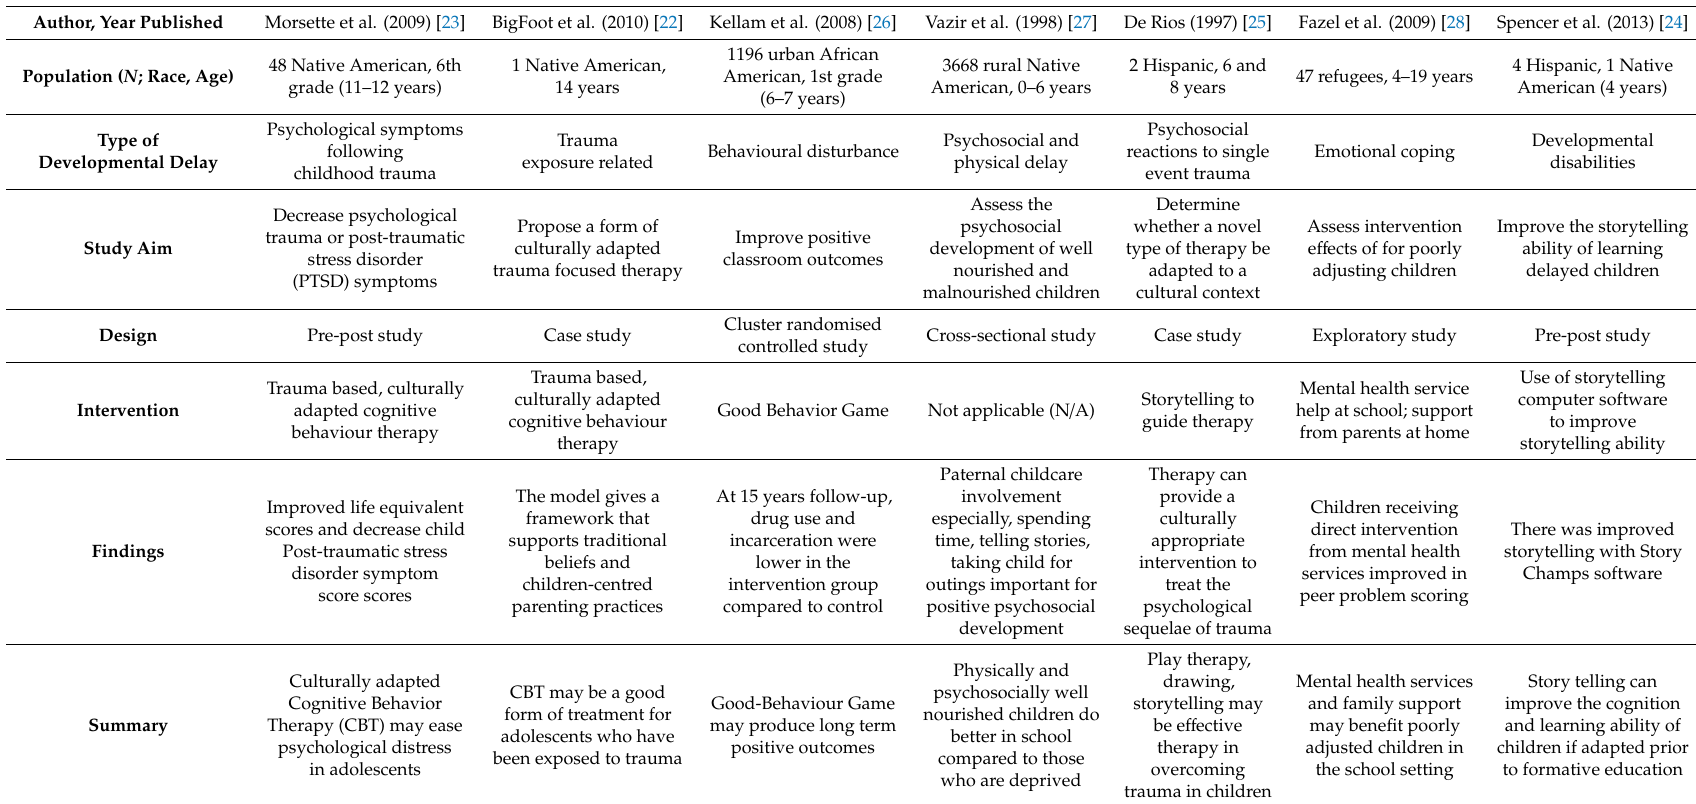
Table 1. Characteristics of the included